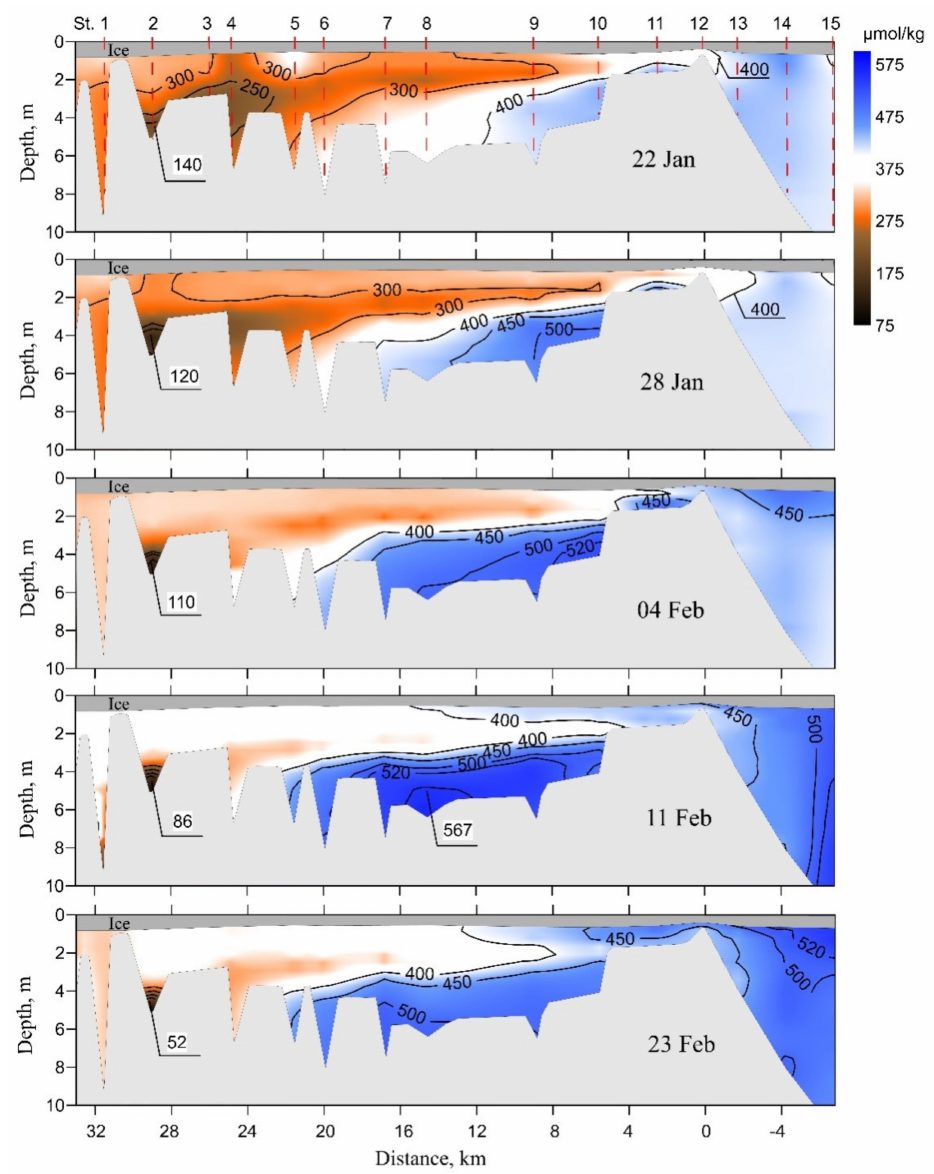
Figure 6. DO concentration on transect obtained from 22 Jan. 2022 to 23 Feb. 2022. The position of monitoring stations is shown by dotted red lines. Positive values on the x -axis—distance from the river mouth bar (St. 12) to upstream, negative values—to